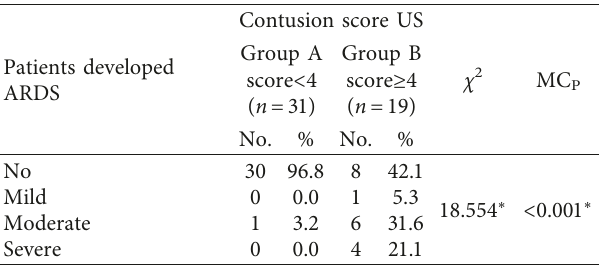
Table 5: Relation between LUS contusion score and development of ARDS.